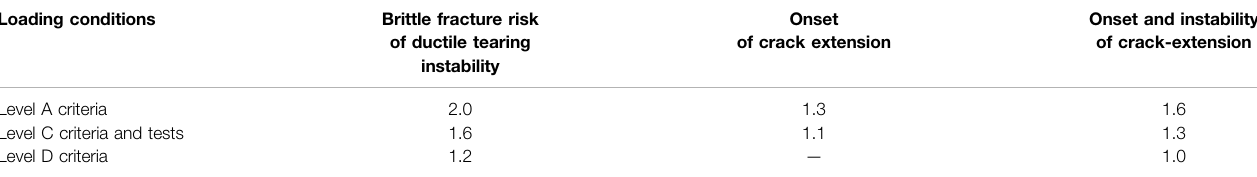
TABLE 1 | Safety margins derived from